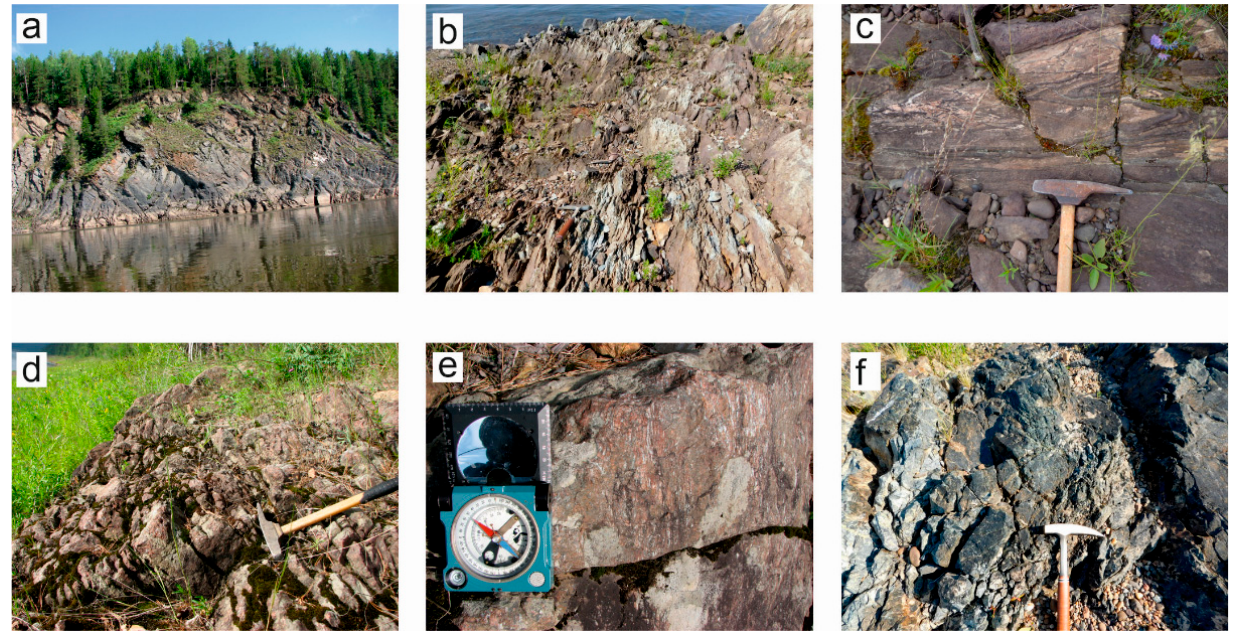
Figure 2. ( a ) Field photos of rock outcrops, ( b ) shear zones of intense deformations, ( c ) strike-sleep displacement with the vertical orientation of the fold axis, ( d ) coarse foliation, ( e ) fine schistosity with the development of linear gneissosity and metamorphic banding, and ( f ) typical rocks for metabasite tectonites of the Transangarian region of the Yenisey Ridge.